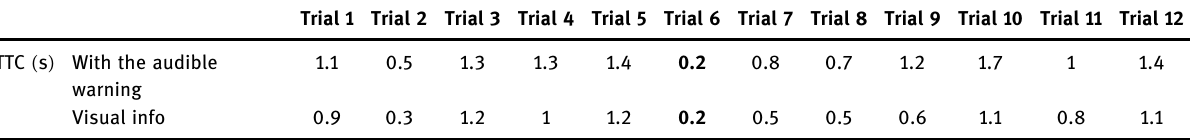
Table 5: Time to the collision from when a warning was issued in the individual trials for scenario 1